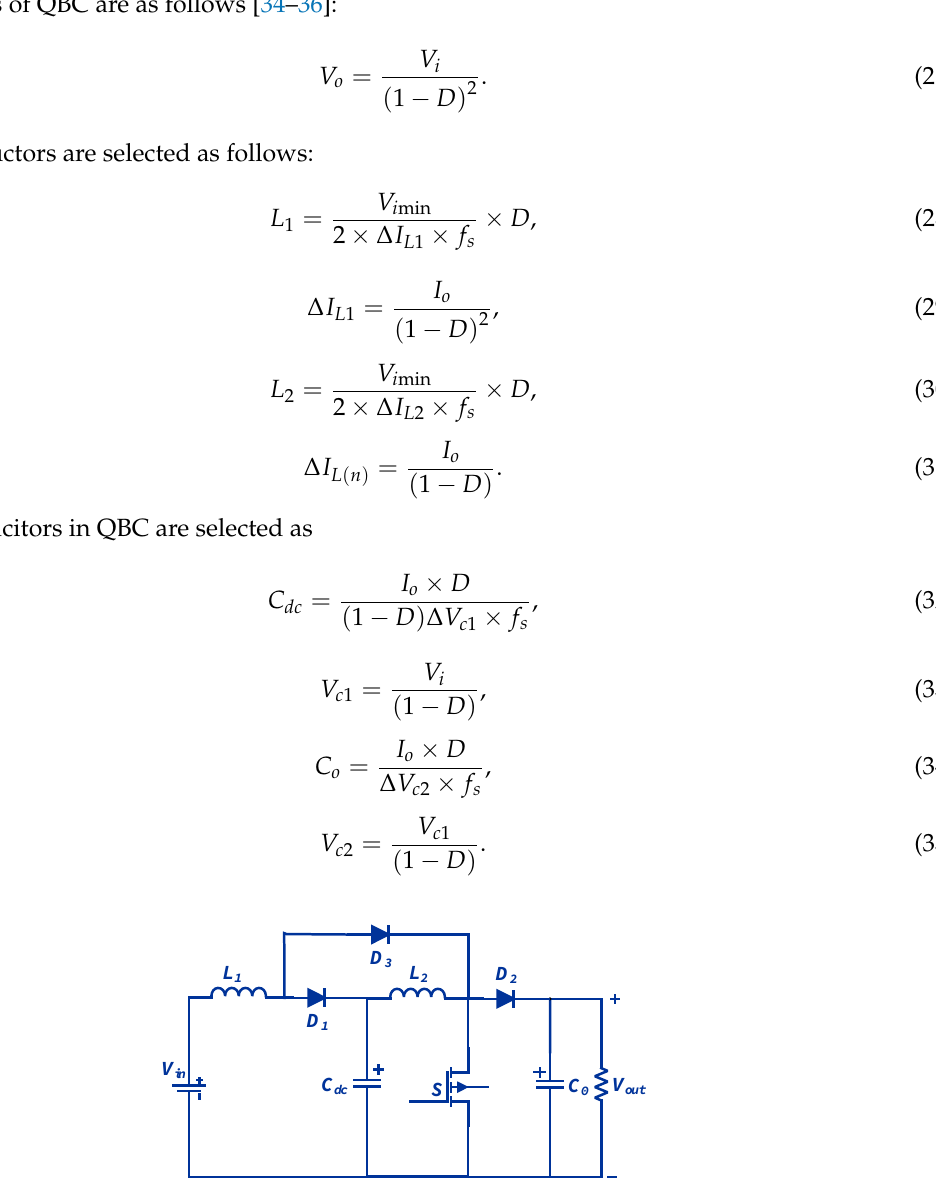
Table 1. Parameters of Aeolos 3 kW system. PMSG: permanent magnet synchronous generator.